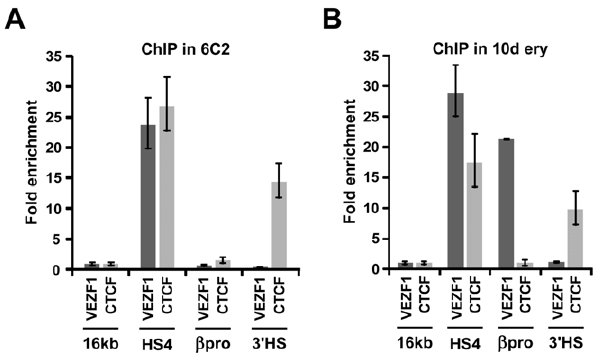
Figure 7. VEZF1 interacts with the HS4 insulator invivo . (A) ChIP analysis of VEZF1 and CTCF interactions at the b -globin locus in (A) 6C2 erythroid progenitor cells or (B) 10 day embryonic erythrocytes. DNA enrichments at the b A promoter or the HS4 and 3 9 HS insulators were normalized to a negative control located in the 16 kb condensed chromatin region upstream of the b -globin locus.